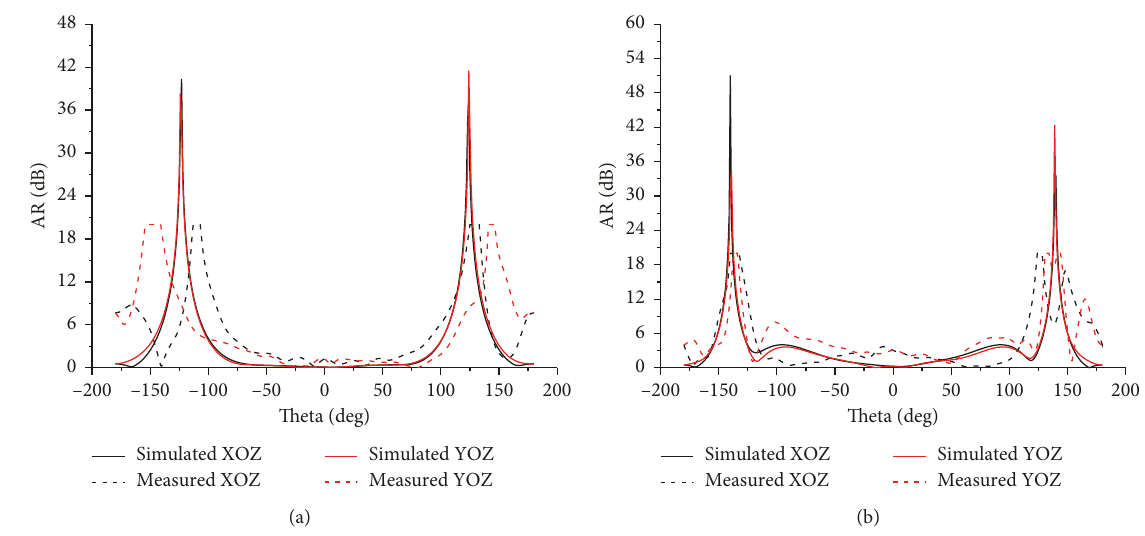
Figure 11: Axial ratio of the proposed antenna at (a) 1.225 GHz and (b)